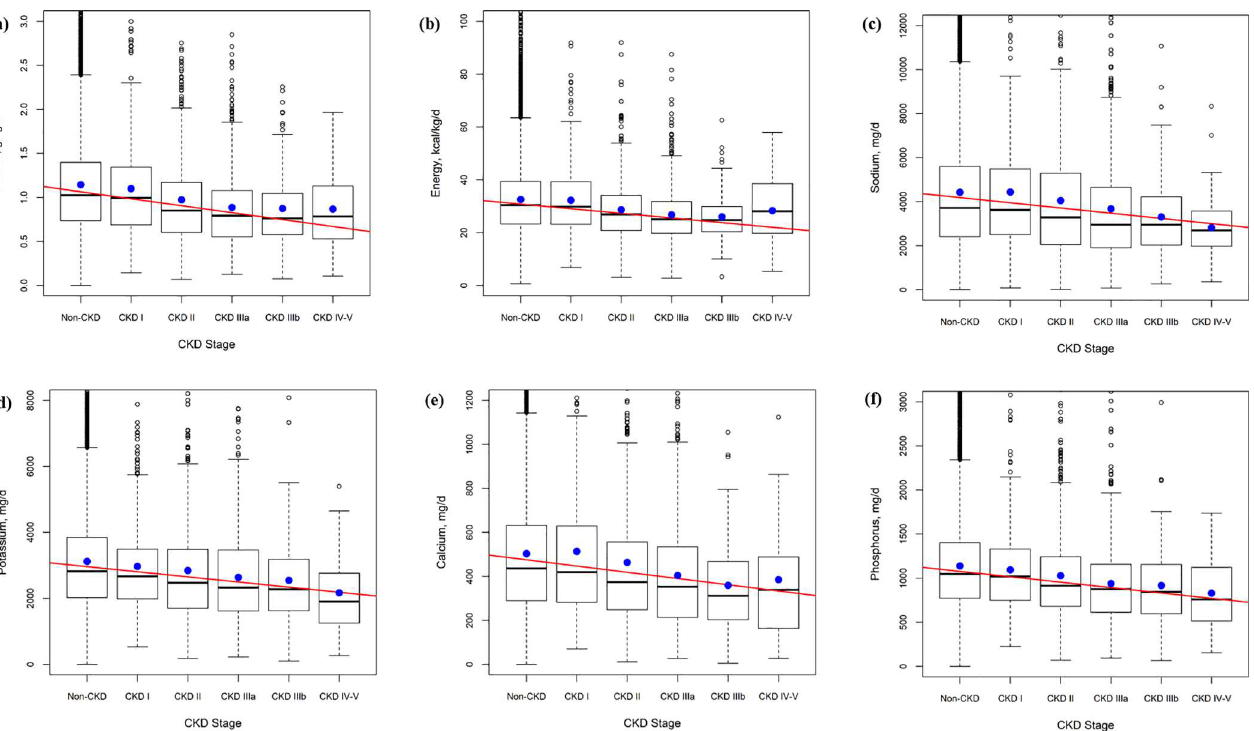
Fig 2. Macronutrient intake according to CKD stages. (a) Protein (b) Energy (c) Sodium (d) Potassium (e) Calcium (f) Phosphorous intake according to CKD stage.